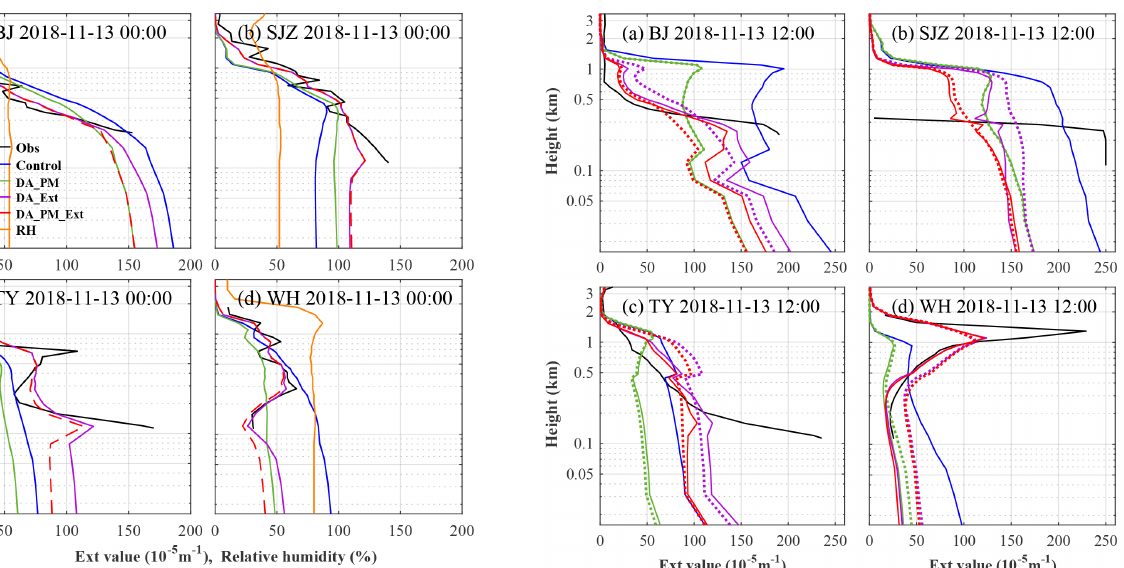
Figure 5. AEC profiles measurements (black lines), the AEC pro- files in the analysis fields of the control (blue lines), DA_PM (green lines), DA_Ext (purple lines), and DA_PM_Ext (red lines) exper- iments and the simulated RH profiles (orange lines) at four lidar stations at 00:00UTC on 13 November 2018 (BJ: Beijing; SJZ: Shi- jiazhuang; TY: Taiyuan; WH: Wuhu).